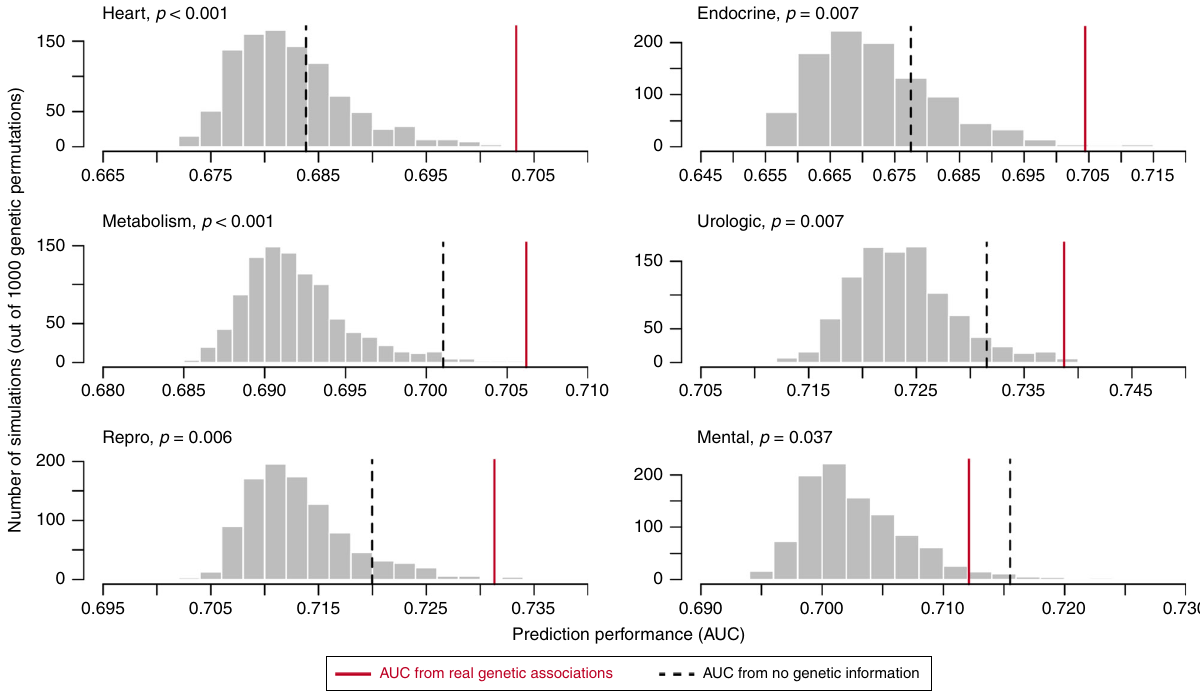
Fig. 4 Results of cross validation analysis of contribution of genetics to predictive modeling. Gray bars show distribution of leave-one-target-set-out cross- validation AUC values from 1000 permutations of the genetic data; dashed line shows the cross-validation AUC value for a model omitting genetic information entirely; red line shows the cross-validation AUC of the regression model with real genetic data. The P -values are derived from the frequency of permutation runs that exceed the AUC of the true model. Source data are provided in Supplementary Table